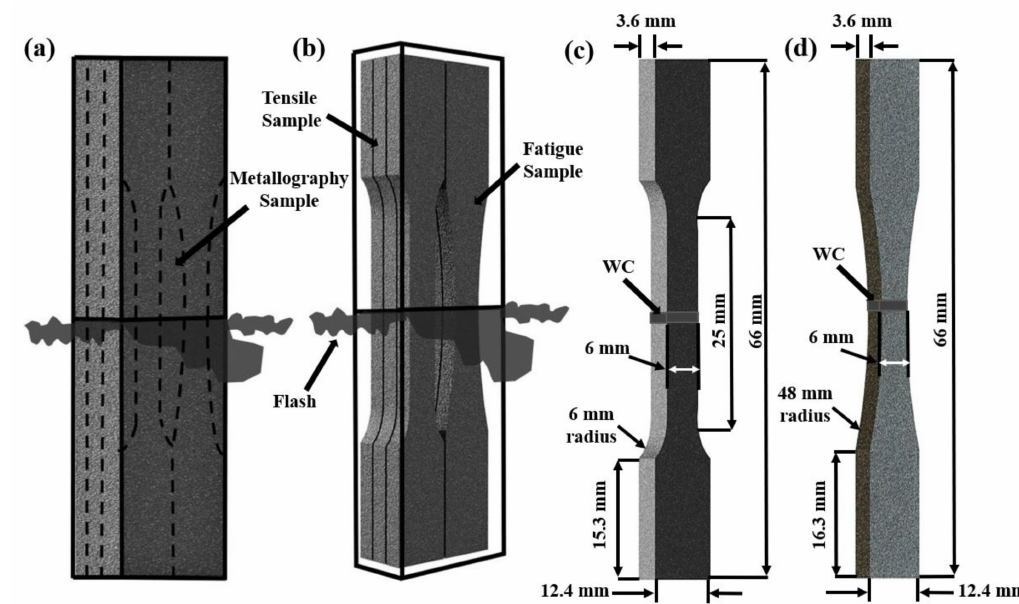
Figure 2. Schematics showing the ( a , b ) EDM plan for extracting the tensile, metallography, and fatigue samples from the welded coupons; ( c ) geometry of the tensile samples; and ( d ) geometry of the fatigue